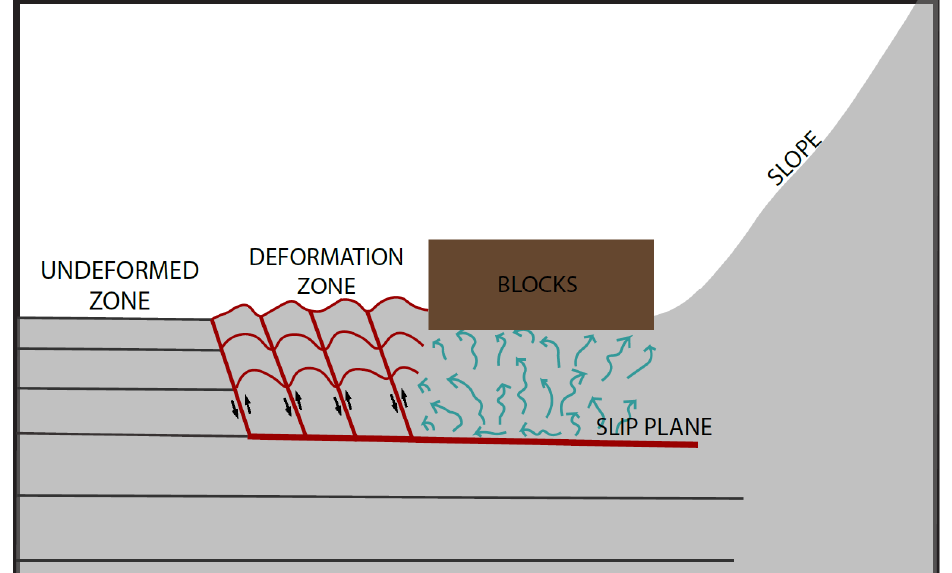
Figure 7. Conceptual model showing undrained pore pressure development immediately after deposition of landslide blocks.